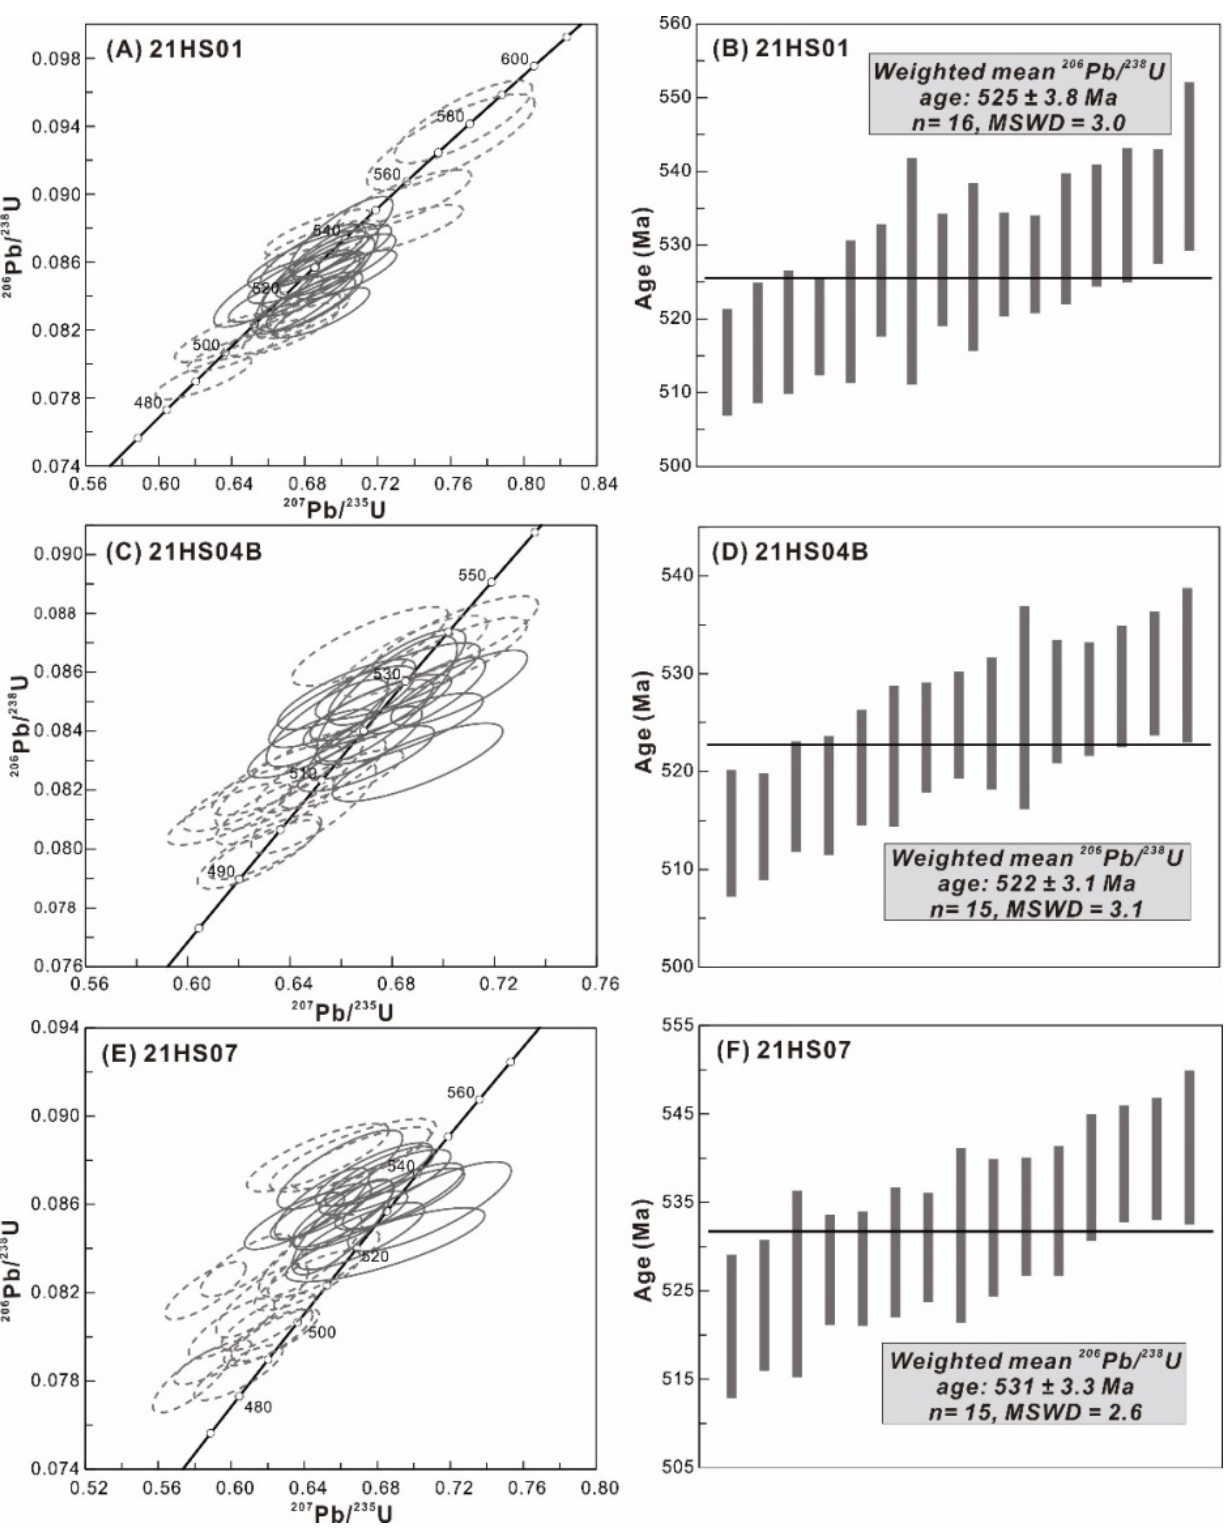
Figure 7. Wetherill U-Pb concordia plots and weighted average plots: ( A , B ) for biotite granitic gneiss (21HS01); ( C , D ) for syeno-granitic pegmatite (21HS04B); ( E , F ) for syeno-granite (21HS07). Table 2. LA-ICP-MS monazite age data from the Abbabis Metamorphic Complex.